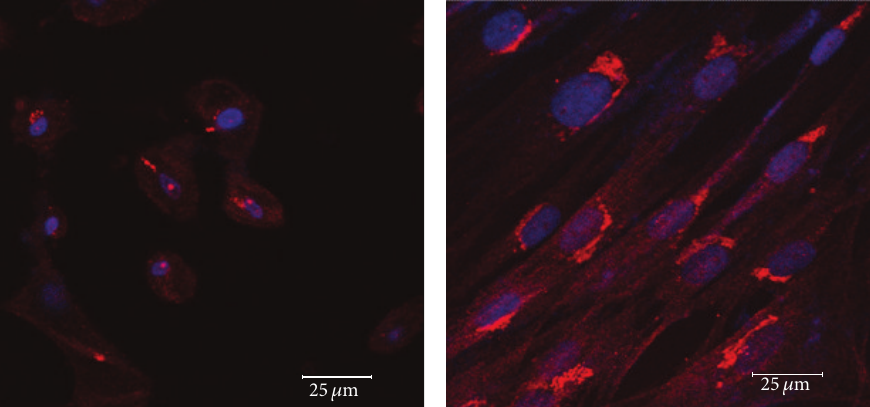
Figure 11: Expression of nestin in undifferentiated and differentiated high passaged eBM-MSCs. Confocal microscopy shows the expression of nestin (red) in neural crest-like cells (left panel) and in undifferentiated controls (right panel) from eBM-MSCs of middle-aged horse after 12h of chemical induction. DAPI was used to stain the nuclei (blue). Note that nestin is inconsistently found perinuclearly or diffusely in the cytoplasm in the differentiated cells. Expression of nestin in the control is perinuclear. Additionally, based on the intensity of the signal, its expression appears less when compared to cells from the low passage. Scale bar = 25 𝜇